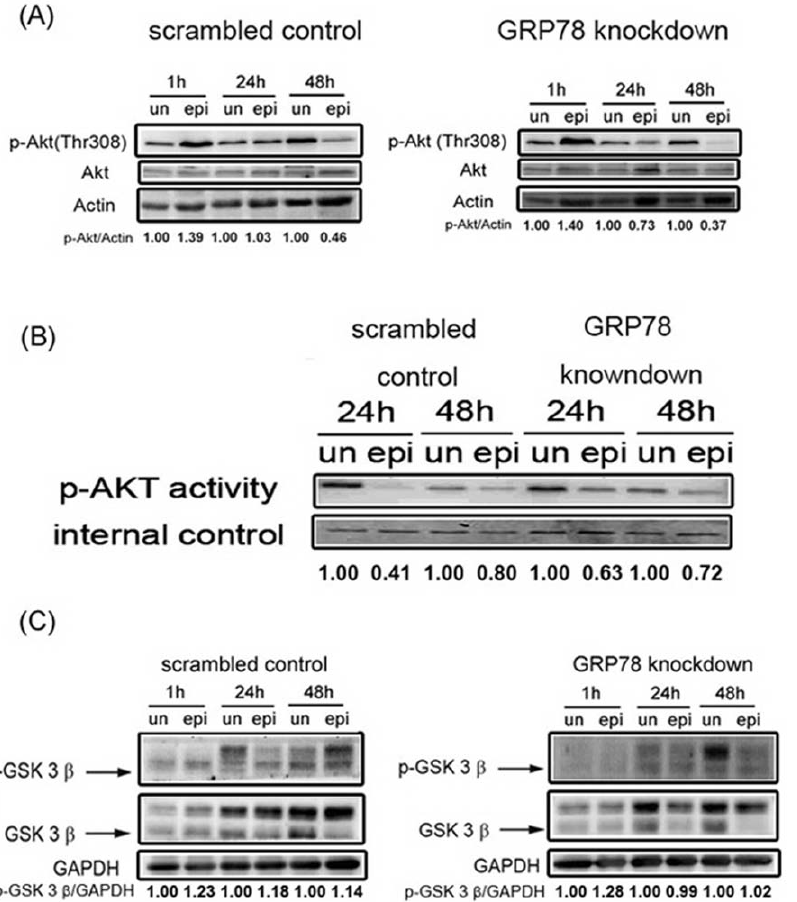
Figure 4. The effect of the Akt pathway on epirubicin (epi) treatment. Scrambled control and GRP78 knockdown DLD-1 cells were treated with epirubicin (500 ng/ml) for the indicated times. The phosphorylation of (A) Akt and (C) GSK 3 b was evaluated by western blotting. (B) Akt activity was determined as outlined in the Materials and Methods . The protein on the PVDF membrane stained with Coomassie brilliant blue is shown as an internal control. These experiments were performed at least 3 times, and a representative experiment is presented.